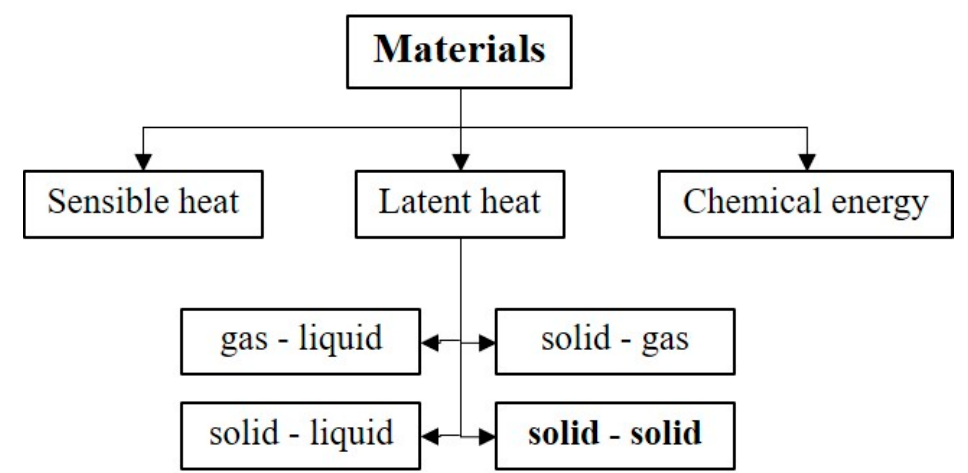
Figure 1. Classification of energy storage materials .